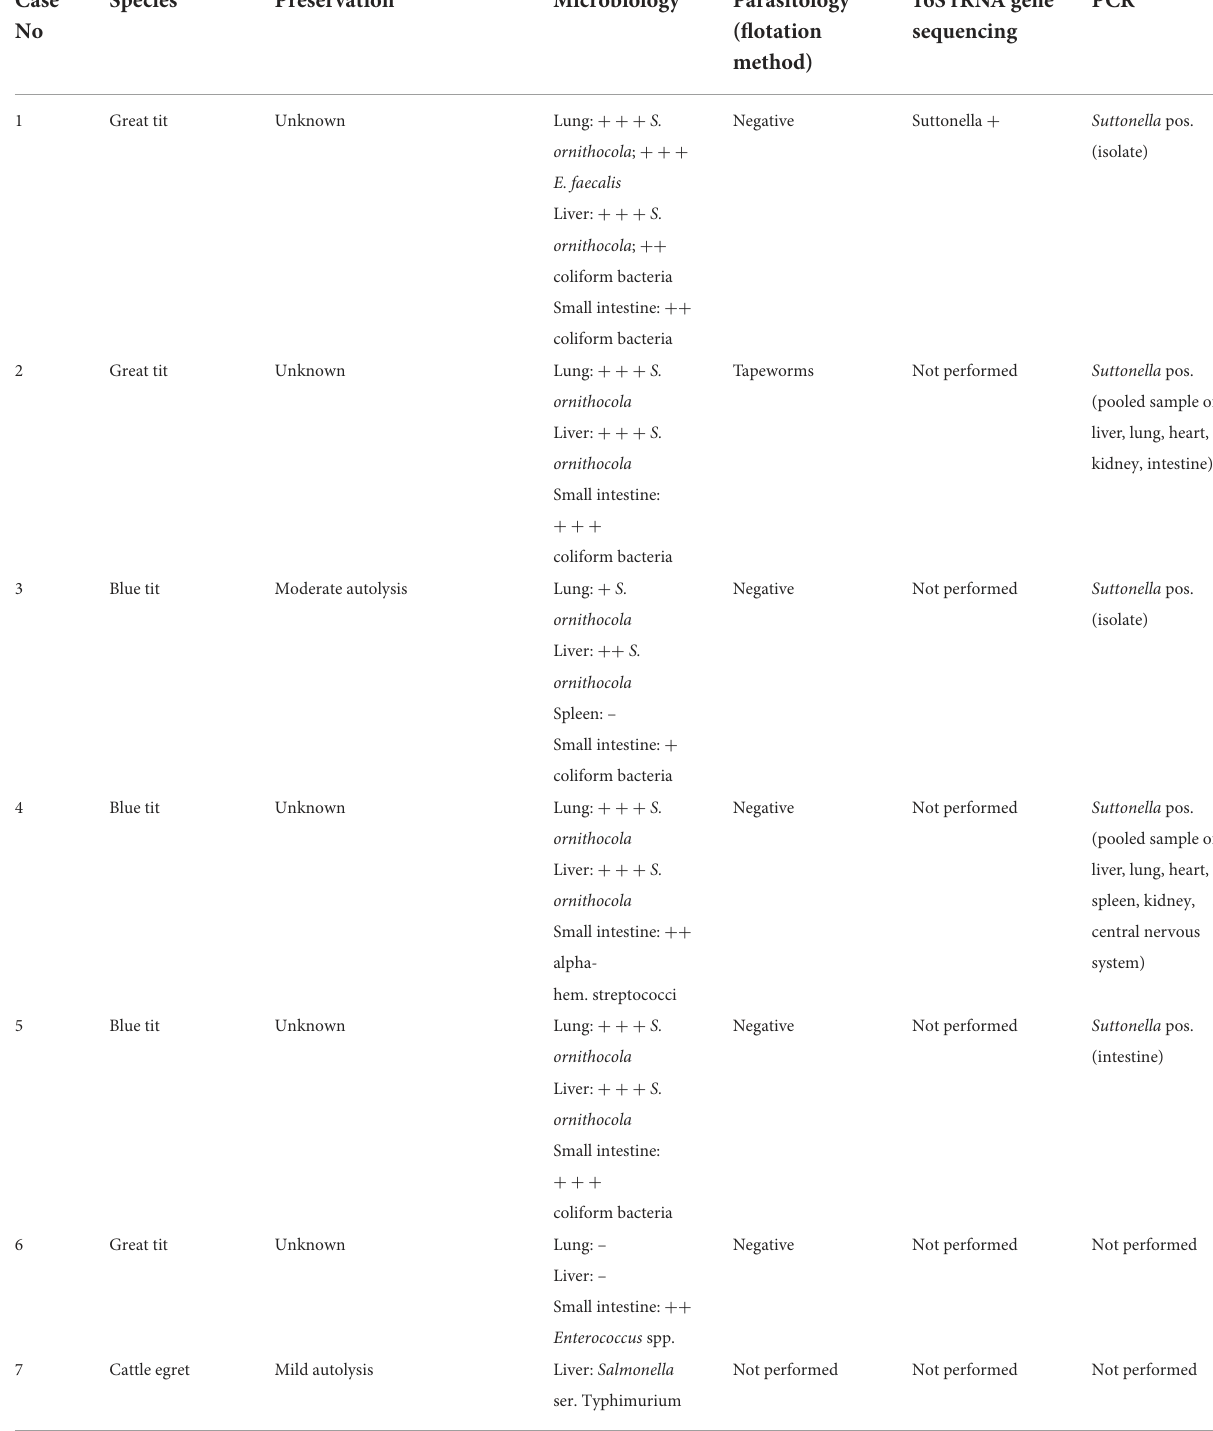
TABLE 1 Overview of the investigated animals, summarizing the results of the microbiological, parasitological, and molecular examinations carried out on the cases